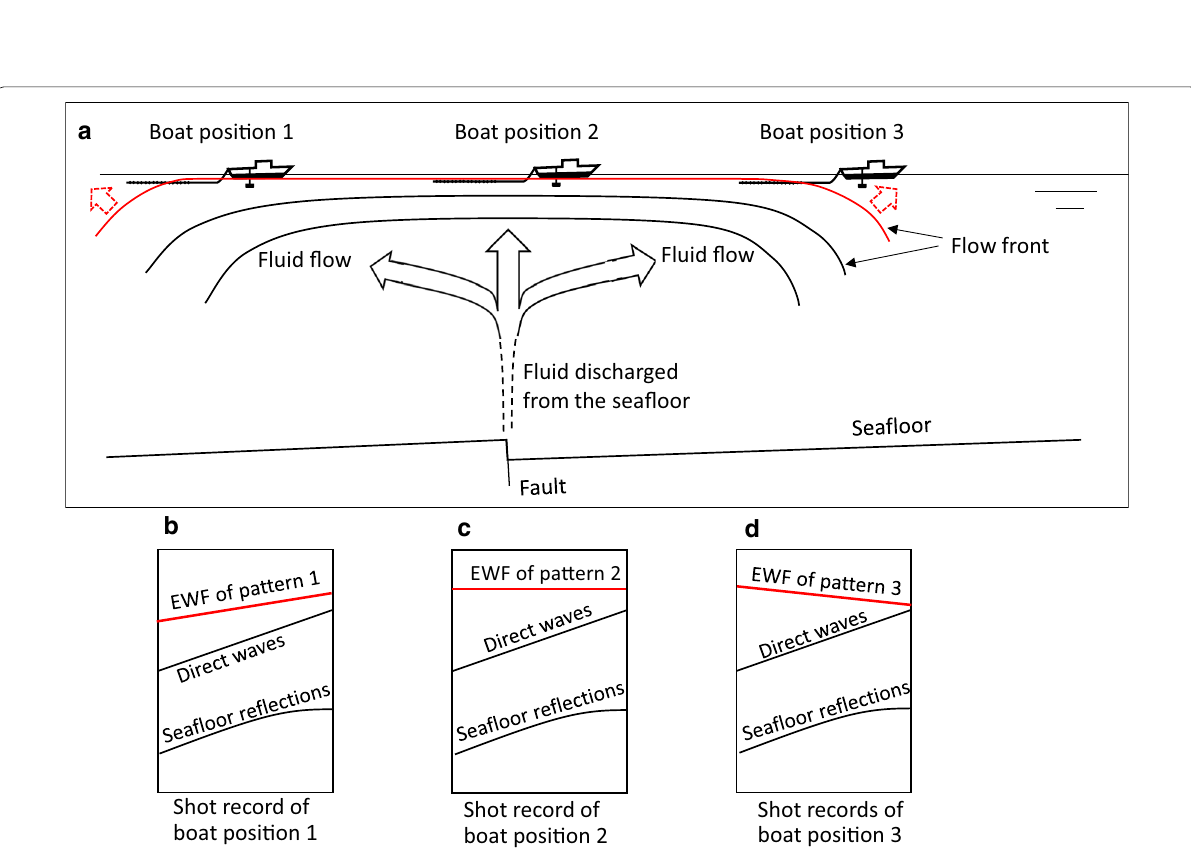
Fig. 11 a Conceptual diagram of a possible cause of the EWF observed on line 10. b This figure shows the EWF of pattern 1 observed in a shot record at boat position 1. c The EWF of pattern 2 in a shot record at boat position 2. d The EWF of pattern 3 in a shot record at boat position